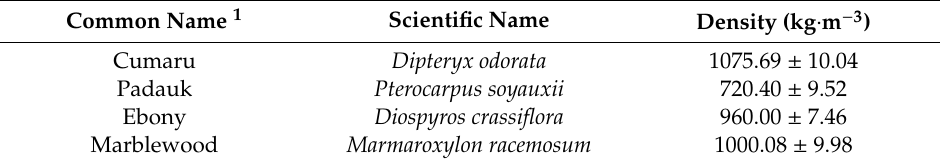
Table 1. Samples used in the